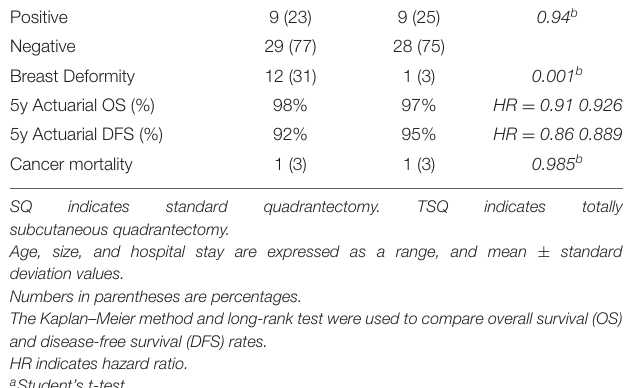
indicates totally